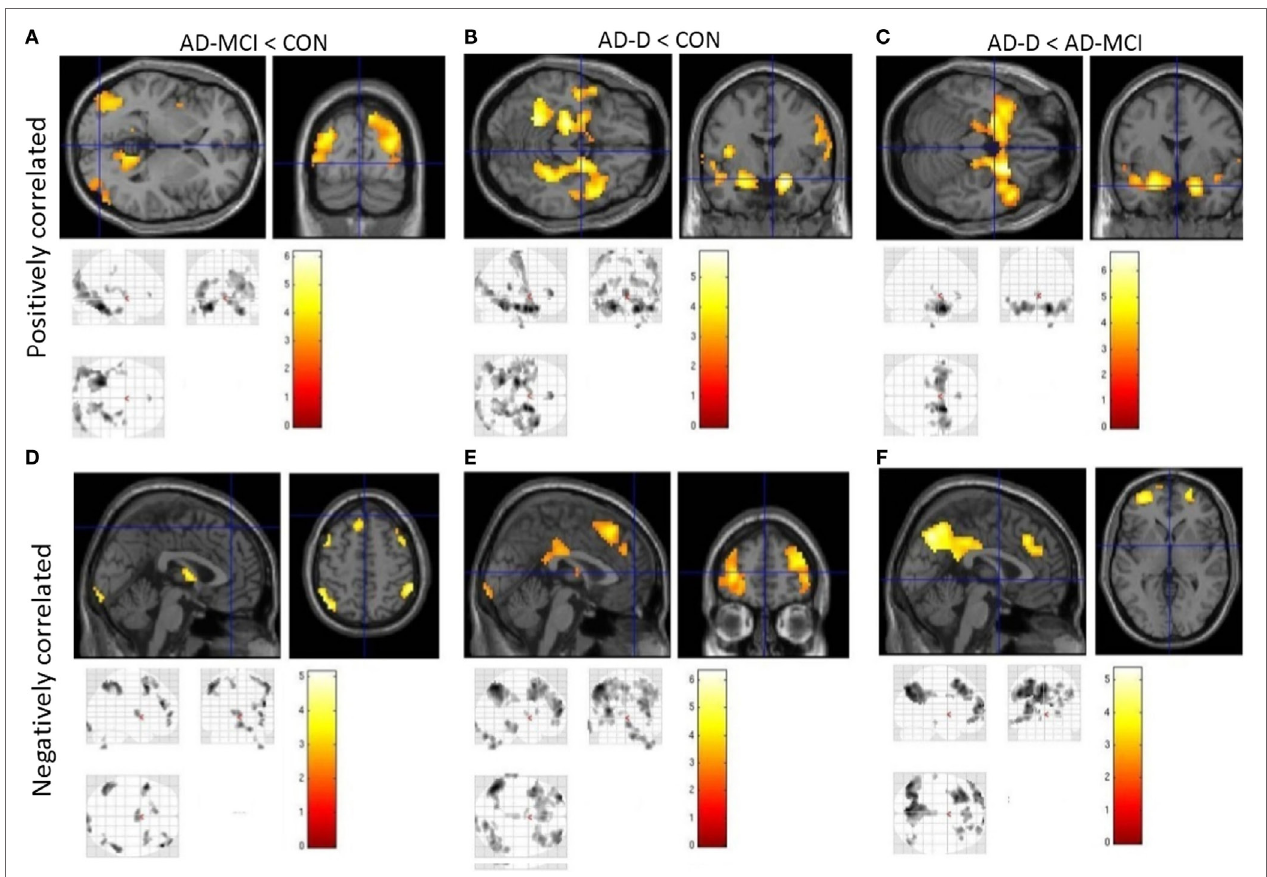
FigUre 4 | group contrasts of amygdala whole-brain functional connectivity, without taking volumetric amygdala differences into account . Upper row (a–c) shows positively correlated activity, lower row (D–F) anticorrelated activity. Columns code different group contrasts: Figures 3a,D CON over AD-MCI; Figures 3B,e CON over AD-D; Figures 3c,F AD-MCI over AD-D. Bars represent T -values, p = 0.05, FWE corrected, cluster size ≥ 20 voxels. Abbreviations: CON, healthy controls; AD-MCI, patients with mild cognitive impairment due to Alzheimer’s disease; AD-D, patients with dementia due to Alzheimer’s